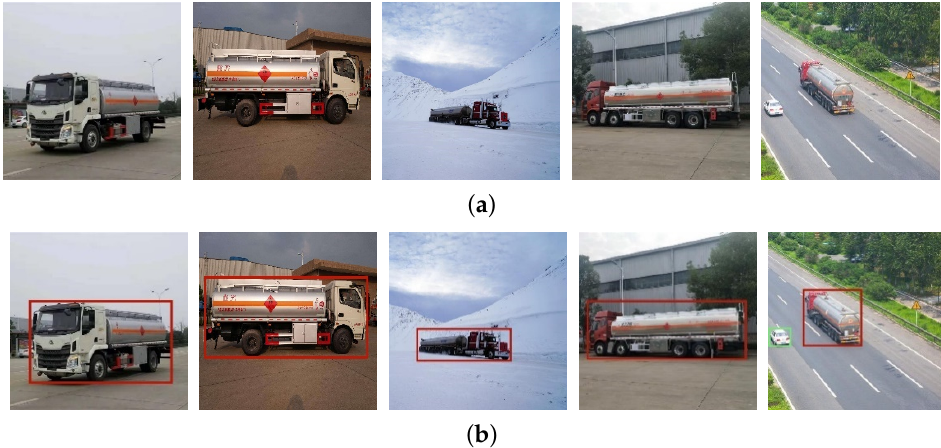
Figure 10. The hazardous material vehicle object detection dataset. ( a ) Hazardous material vehicle images samples. ( b ) Ground-truth with bounding